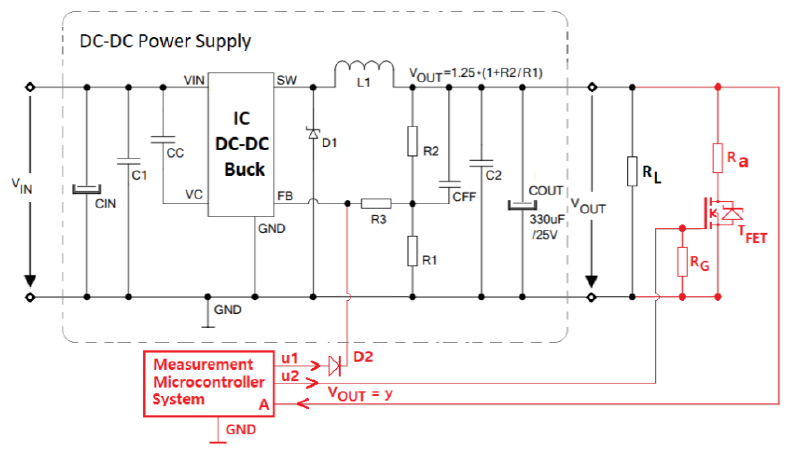
Figure 12. Diagram for determining the transient equivalent values of the COUT capacitor parameters.